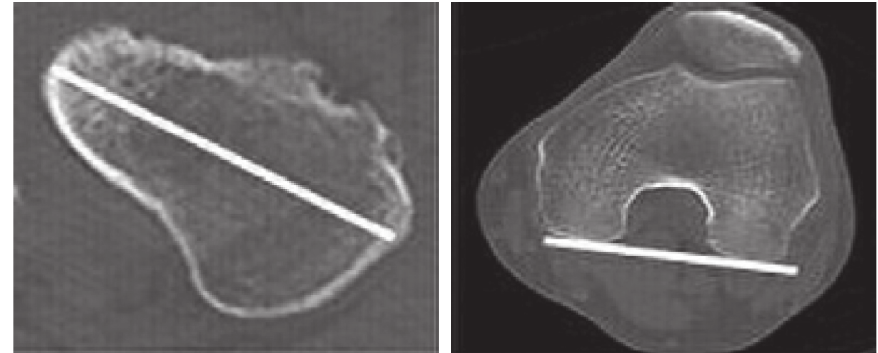
Figure 1: Femoral neck anteversion angle. The femoral neck anteversion angle is measured by identifying the femoral head-neck axis from the CT horizontal section slice just beneath the femoral head, with reference to the posterior condylar